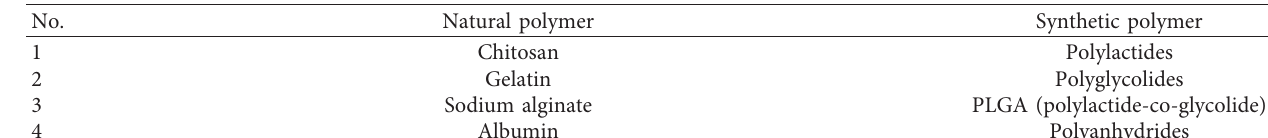
Figure 1: Difference in the nanosphere and Table 1: Classification of polymers.